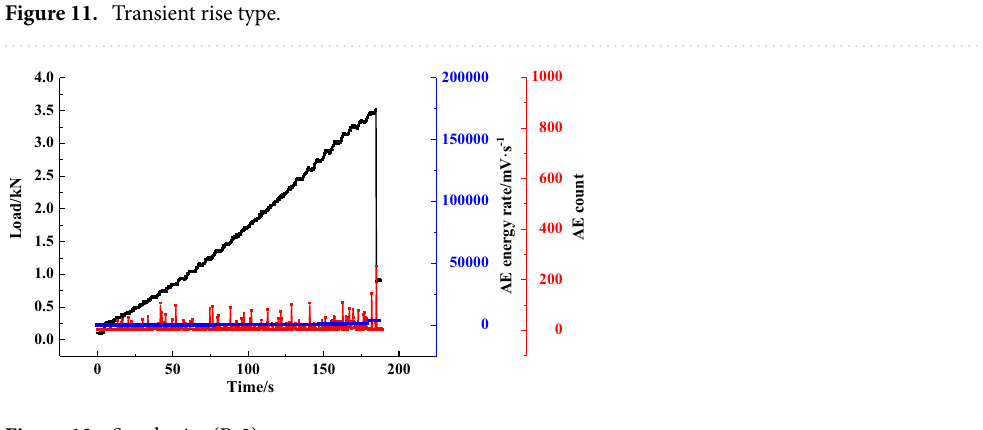
Figure 11. Transient rise type.